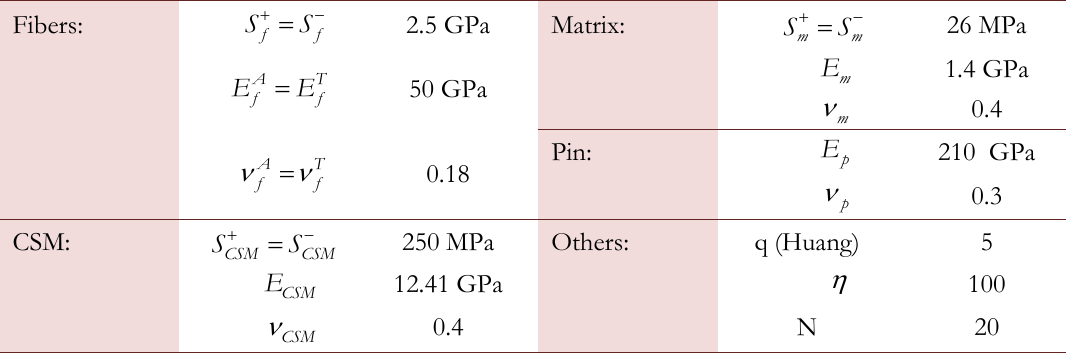
Table 1: Undamaged material properties of the layer constituents, CSM, pin and other model parameters [10,14,17,16].